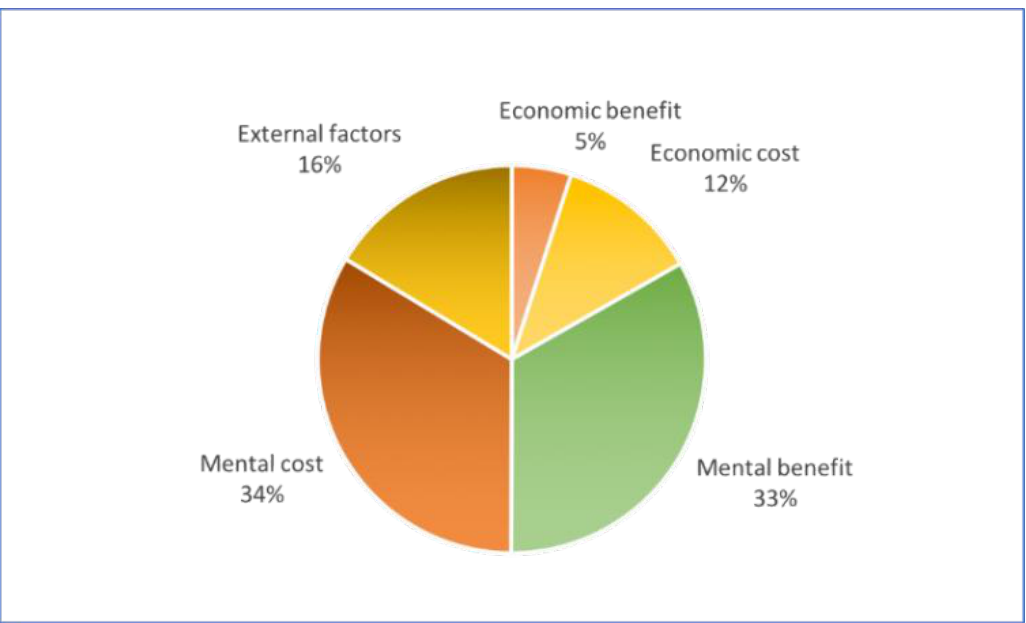
Figure 5. The frequency of keywords mentioned for each category.